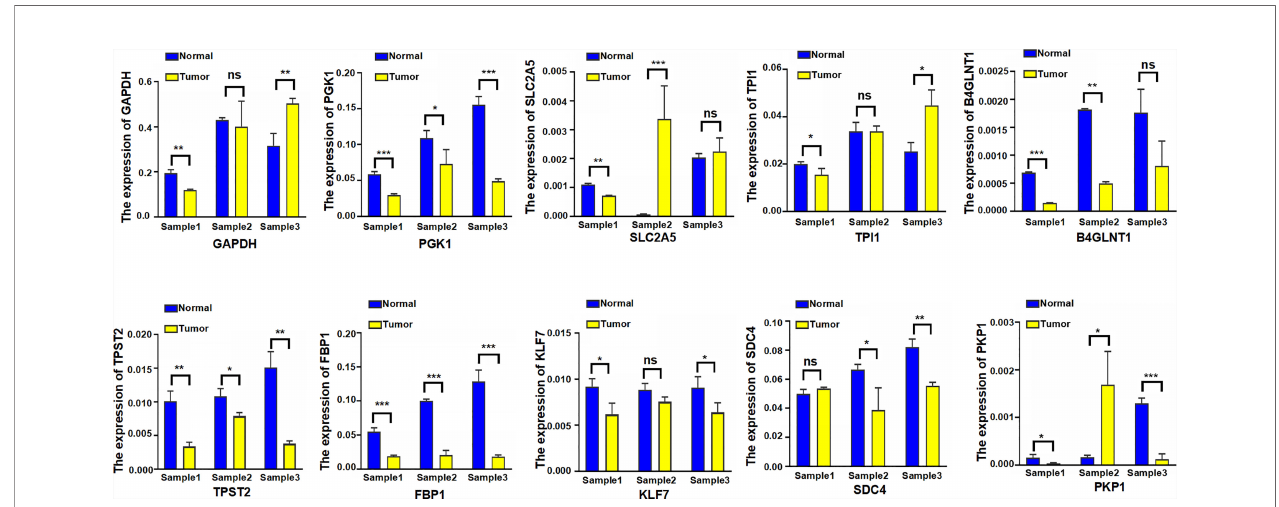
FIGURE 14 | The expression level of 10 hypoxia-associated genes were veri fi ed at transcript levels by using three paired samples of LUAD tissues and the paired non-tumorous lung tissues. Sample1, Sample2, and Sample3 were collected from three different LUAD patients; each sample was used to detect 10 hypoxia- associated genes simultaneously. *p < 0.05; **p < 0.01; ***p < 0.001; ns, not signi fi